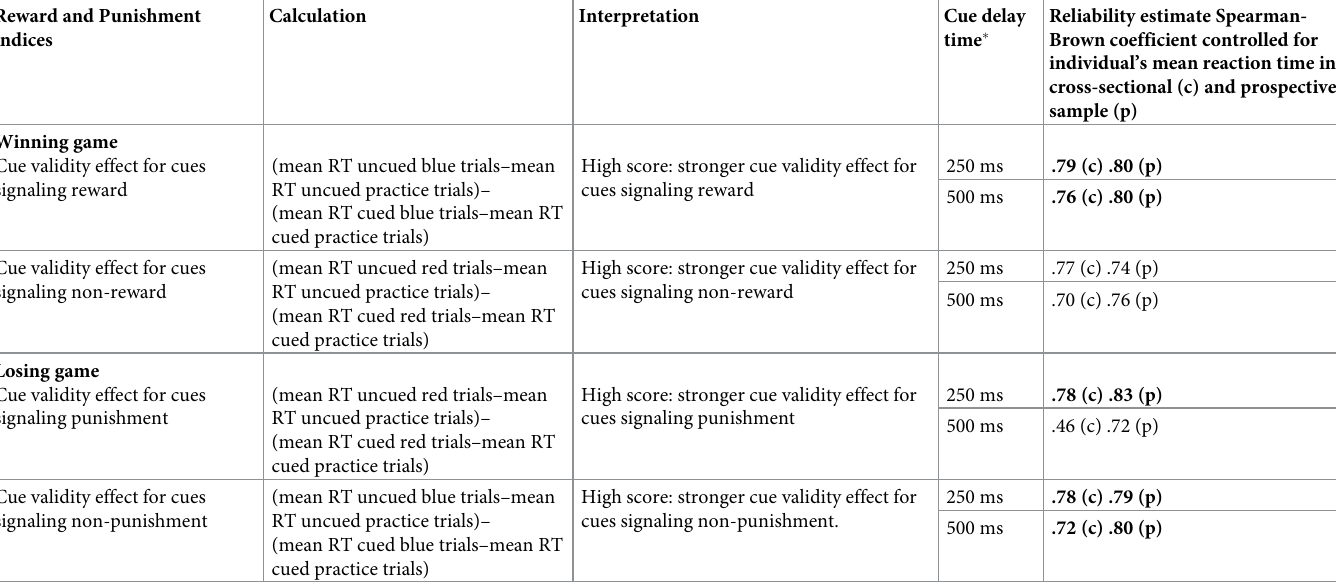
Table 2. Calculation of the cue validity effects controlled for mean reaction time, the interpretation of the cue validity effects, and reliability estimates in the cross- sectional and prospective sample. Reward and Punishment